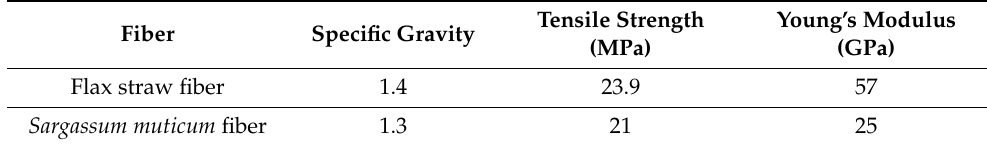
Table 3. Physical properties of fibers used in this study.